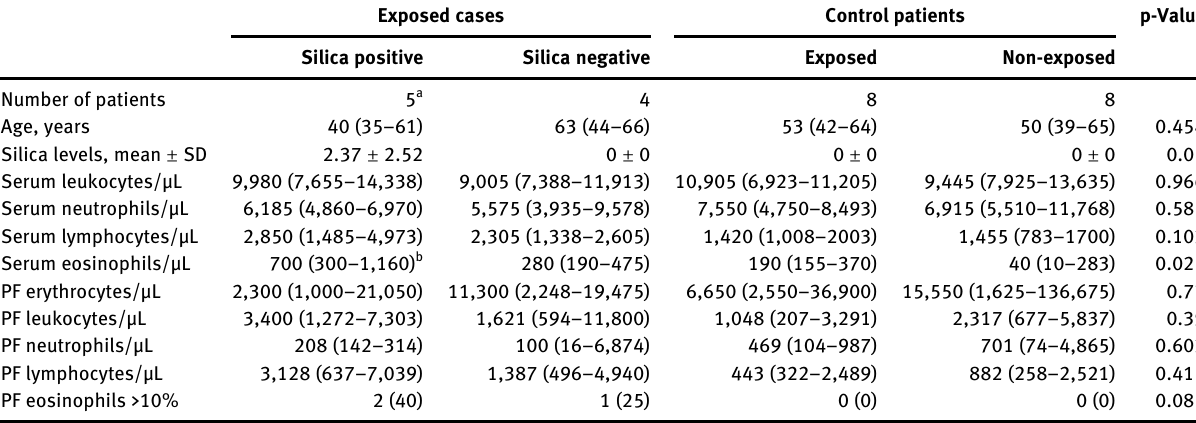
Data are presented as median (interquartile range) or number (percentages) unless otherwise specified. a Including one patient with demonstrablesilicaonpleuralbiopsy,inwhomnoPF wasavailable forsilicadetection. b Signi fi cantly higherthanthe respective valuesinother groups by post-hoc test. PF, pleural fl uid; SD, standard